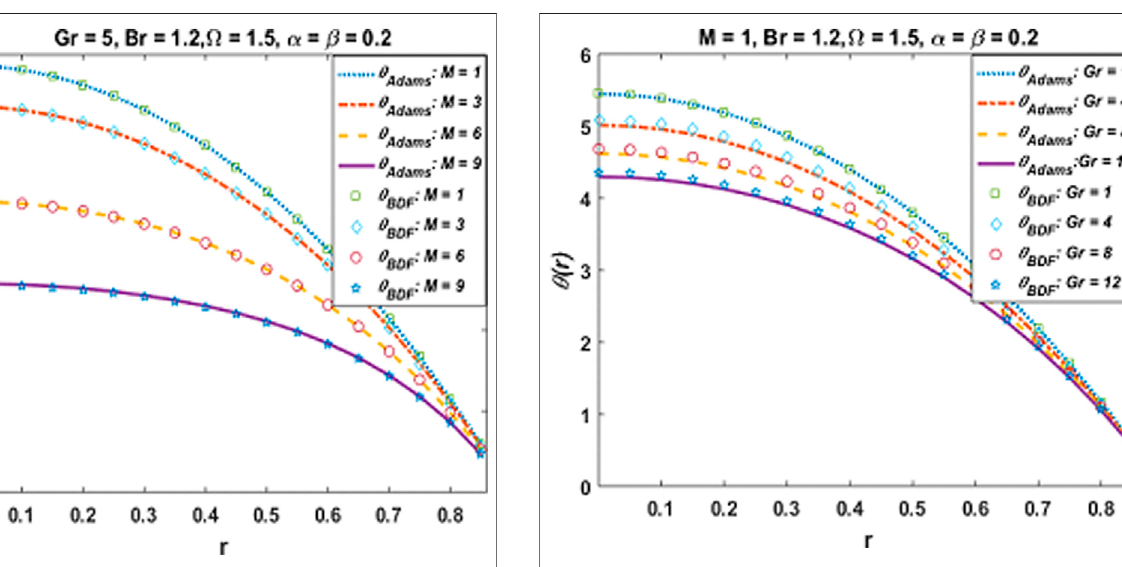
FIGURE 13 | Behavior of temperature pro fi le against Grashof number.